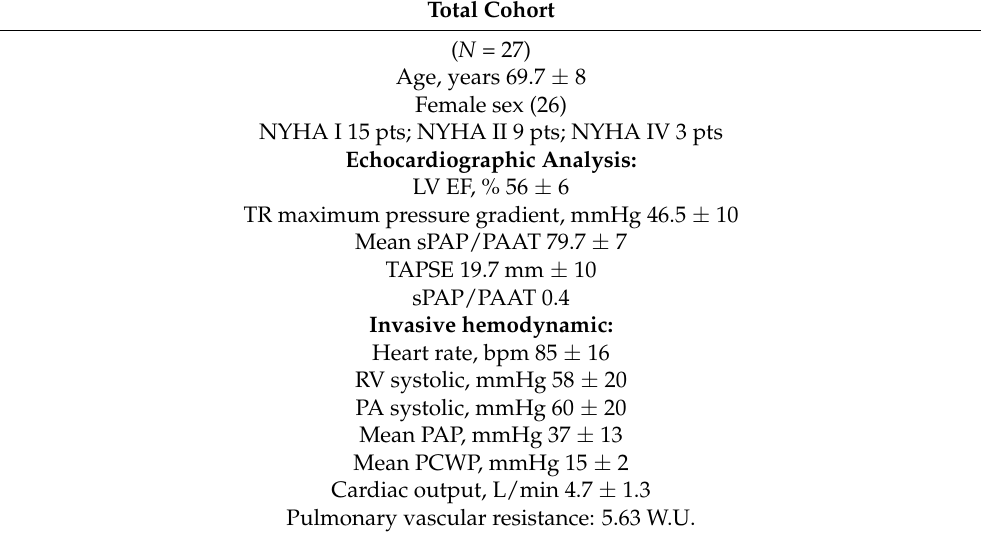
Table 2. Baseline demographic, clinical, and hemodynamic characteristics of patients with sclero- derma and pulmonary